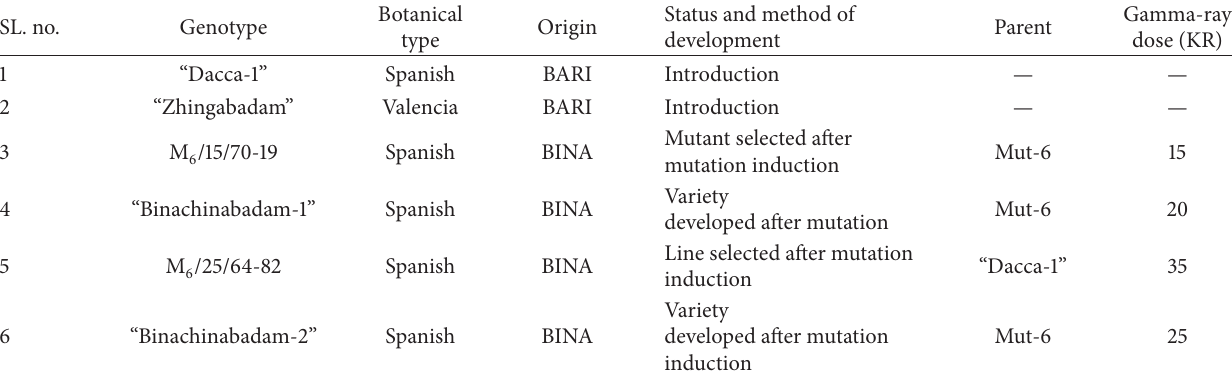
Table 1: Origin/sources of the groundnut genotypes used in this experiment together with method of development. SL.